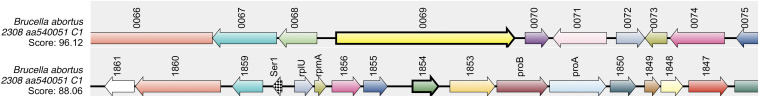
The location of the BatA encoding gene in the genome of B. abortus 2308. Different loci are presented with arrows of different colors. The locus tags are at the top of each arrow. BAB1_0069 and BAB1_1854 are trimeric autotransporter encoding genes.